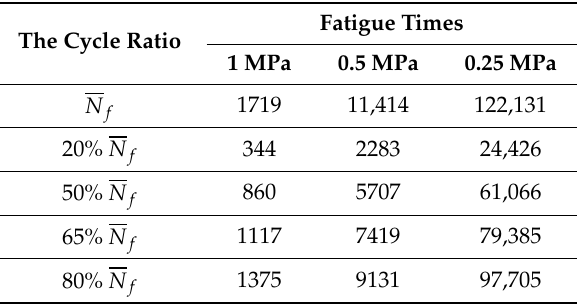
Table 10. Design fatigue times at different stress levels.